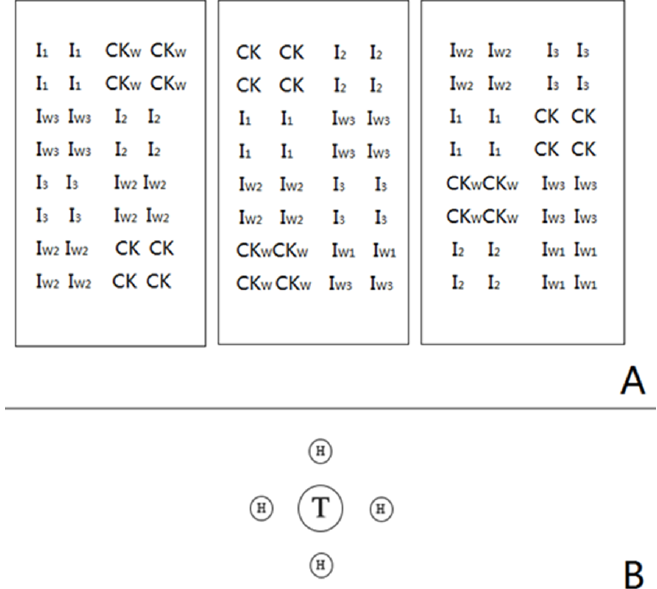
Figure 1. ( A ) The layout of the field test for ectomycorrhizal (EMC) fungi inoculation. I 1 –I 3 : three inoculated treatments (200 mL, 400 mL, and 600 mL) with dry inoculum; Iw 1 –Iw 3 : three inoculated treatments (200 mL, 400 mL, and 600 mL) with moist inoculum; CK W and CK: two non-inoculation treatments using 600 mL moist sterilized inoculum (CK W ) or dry sterilized inoculum (CK). The spacing within the rows was 1 m; the spacing between rows was 1 m; ( B ) The method for the inoculation test: T: inoculated plants; h: holes.